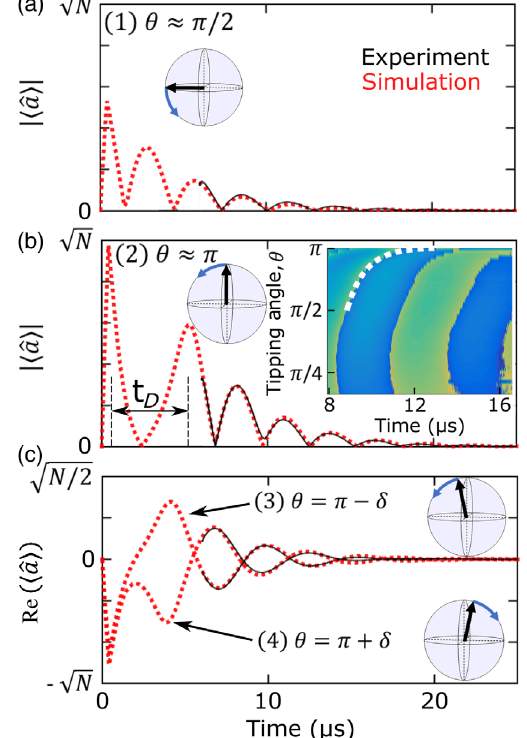
FIG. 7. Comparison of individual FID traces taken as horizontal slices from Fig. 6 for selected rotation angles ( θ ) of the micro- wave pulse. The initial pseudospin state is illustrated on the Bloch sphere for each case (inset). (a),(b) Traces (1) and (2) correspond to rotation angles of θ ≈ π = 2 (initial pseudospin state j S; 0 i ) and θ ≈ π (initial pseudospin state j S; S i ), respectively. All oscilla- ffiffiffiffi p N tions in trace (1) occur at a rate close to g . In contrast, trace (2) evolves more slowly with a long delay ( t ) in the FID D oscillations occurring at the first minimum where the pseudospin ffiffiffiffi p N reaches full inversion. The rest of the FID trace oscillates at g so that this initial delay shows up as an overall phase shift. Inset in (b): A zoomed-in part of the two-dimensional FID plot from ð M Þ according to Fig. 6 with a fit (white dashed curve) to t D Eq. (5). (c) Traces (3) and (4) correspond to slight under- or overrotation with respect to the fully inverted state of the pseudo- spin ( θ ≈ π (cid:3) δ , with δ ¼ 9 deg). The phases of the microwave emission are opposite in these two traces since the pseudospin precession reverses direction in the underrotated case but continues in the same direction in the overrotated